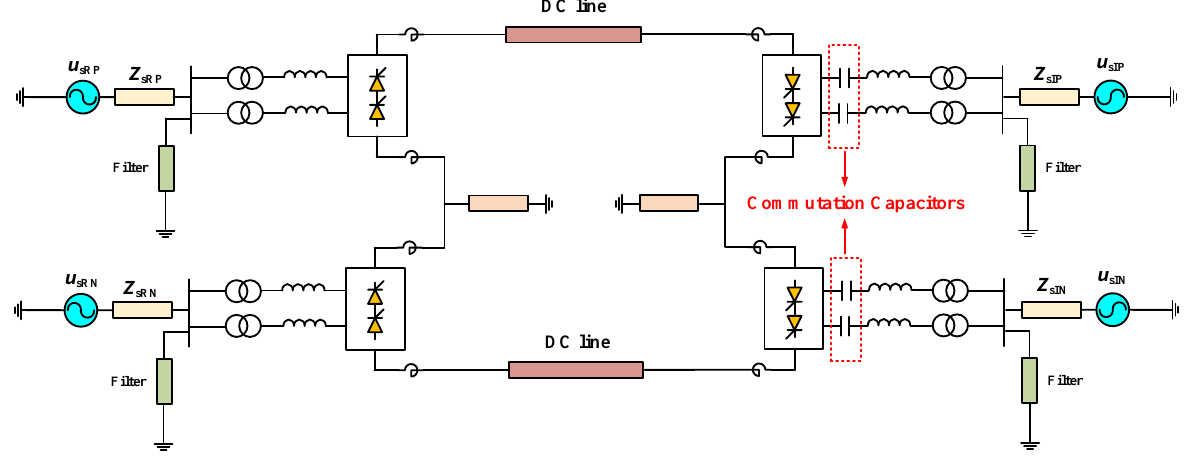
Figure 1. Topology of the two-terminal LCC-CCC HVDC transmission system.